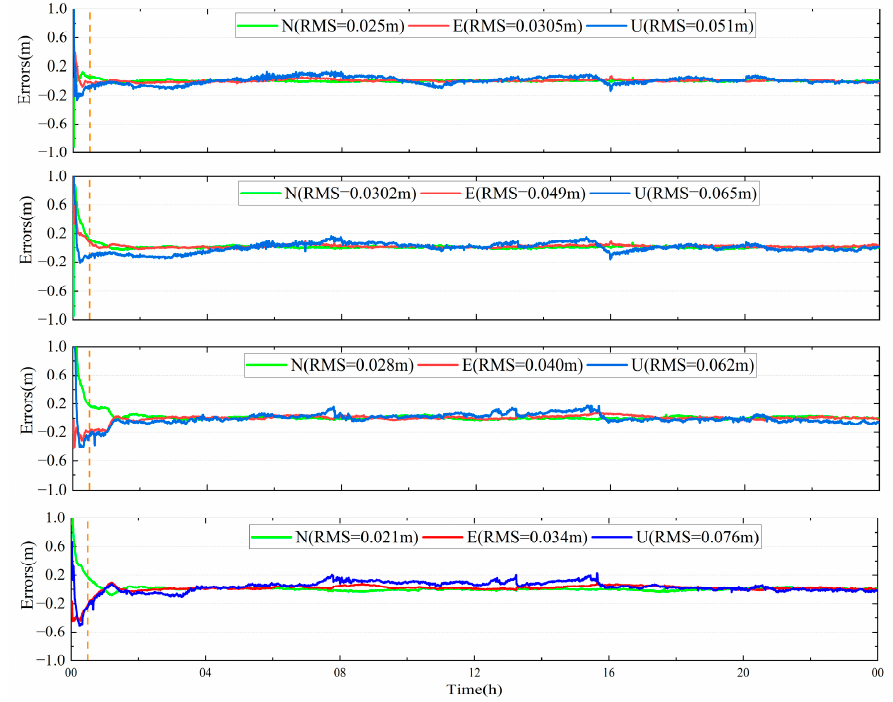
Figure 9. PPP-B2b position errors for GAMG in the simulated kinematic mode (8 March 2022).